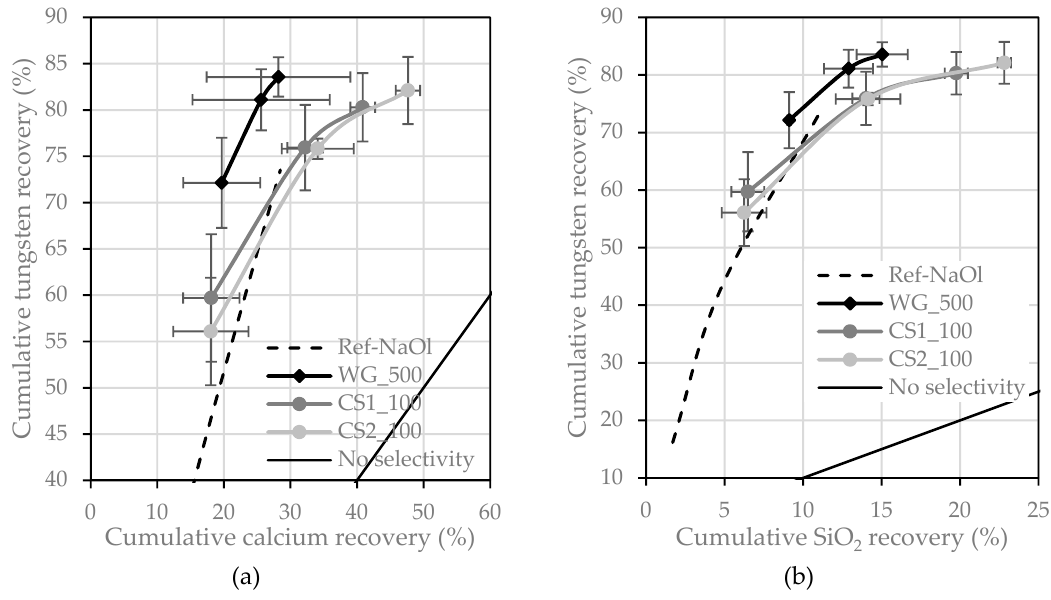
Figure 4. Selectivity curves of tungsten against ( a ) calcium (calcium contained in scheelite was subtracted) and ( b ) silica (error bars represent the 95% confidence interval).